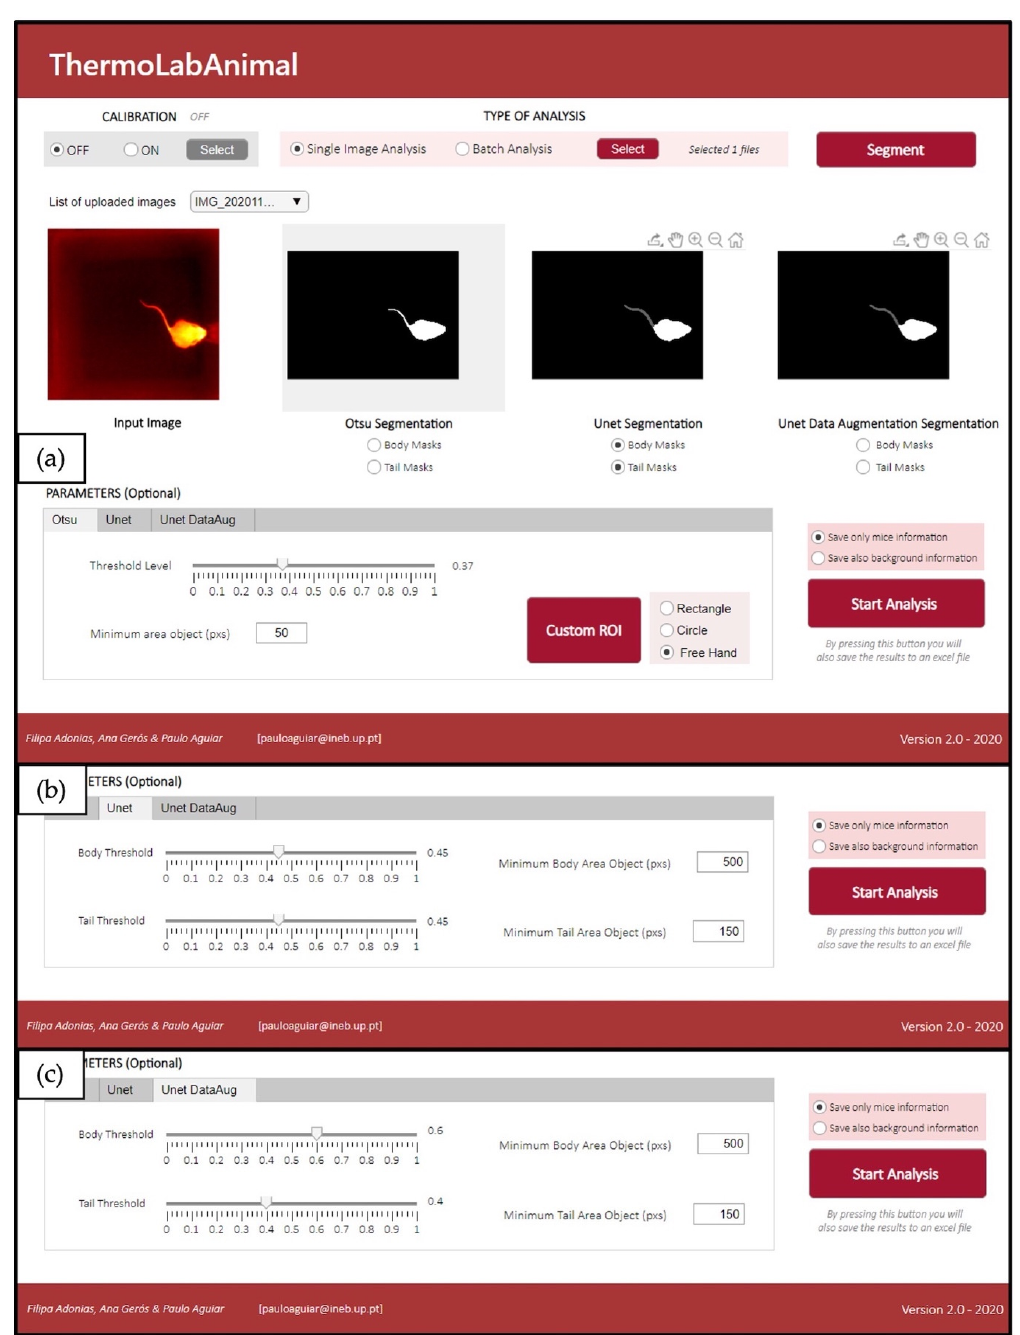
Figure A1. Image presenting ThermoLabAnimal 2.0 main interface, which allows automatic segmen- tation of the animal (body and tail) in two steps. First, it is possible to choose the type of analysis: single-image analysis or batch analysis. Second, parameters for each one of the segmentation methods can be fine-tuned: ( a ) in Otsu’s method, it is possible to adjust for threshold level (minimum area of pixels detected) and to manually select the region of interest (Custom ROI); ( b ) in the U-Net- based method it is possible to adjust body and tail threshold level (minimum area of pixels detected) to improve the quality of segmentation; ( c ) uses the same U-Net as in ( b ) but trained with an augmented dataset (which, in some cases, may provide improved